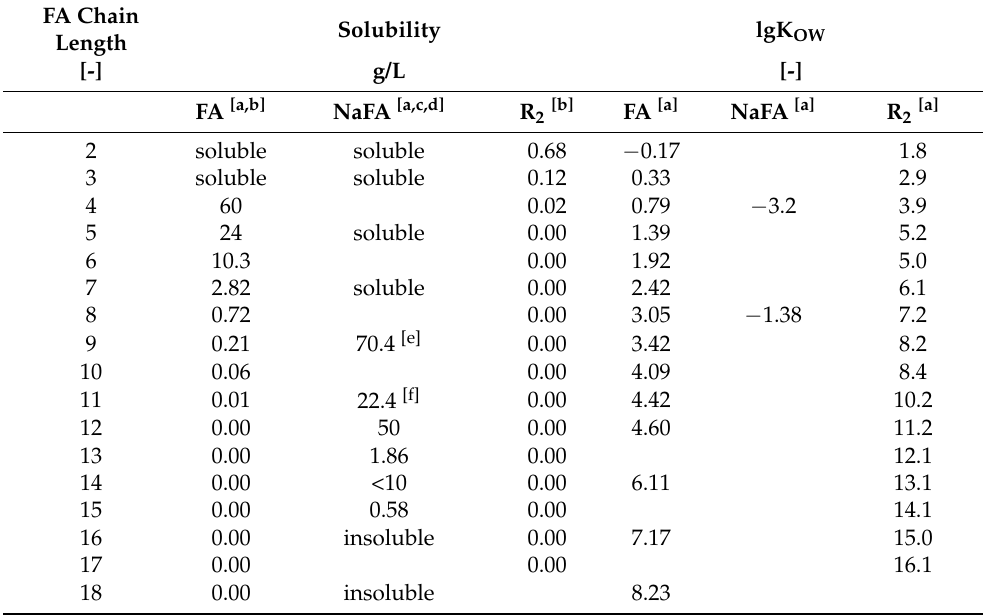
Table 1. Aqueous solubility and logarithmic Octanol/Water partition coefficient (lgK OW ) of fatty acids, their sodium soaps (NaFA) and the corresponding Kolbe dimeric product (R 2 ); aqueous solubility at 25 ◦ C unless stated